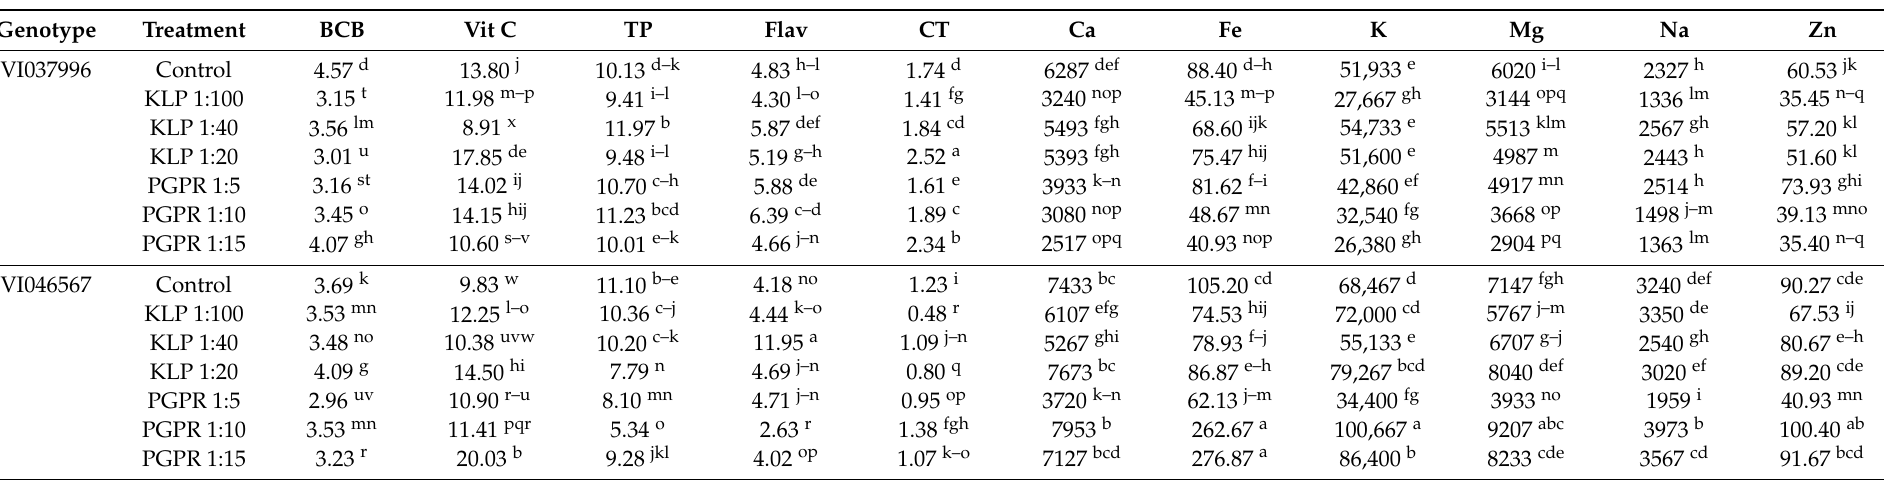
Table 5. Interaction effect of genotypes and biostimulants on Abelmoschus esculentus nutritional and phytochemical contents. In each column, values followed by different letters indicate statistically significant ( p ≤ 0.05) differences. KLP = Kelpak ® dilutions, PGPR = plant growth promoting rhizobacteria, BCB = β